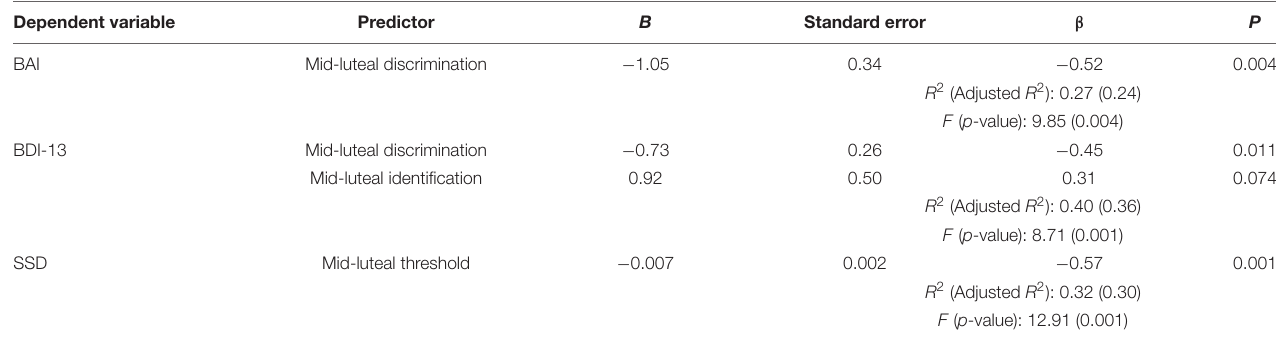
FIGURE 3 | Relationships between olfactory discrimination and emotional symptoms and between olfactory threshold and behavioral impulsivity in different menstrual phases. (A,D) Correlations between BAI and odor discrimination scores in the late follicular (A) and mid-luteal (D) phases. (B,E) Correlations between BDI-13 and odor discrimination scores in the late follicular (B) and mid-luteal (E) phases. (C,F) Correlations between SSD (in seconds) in the stop-signal task and odor threshold score in the late follicular (C) and mid-luteal (F) phases. ** p < 0.01 (uncorrected). TABLE 2 | Linear regression models predicting emotional symptoms and behavioral